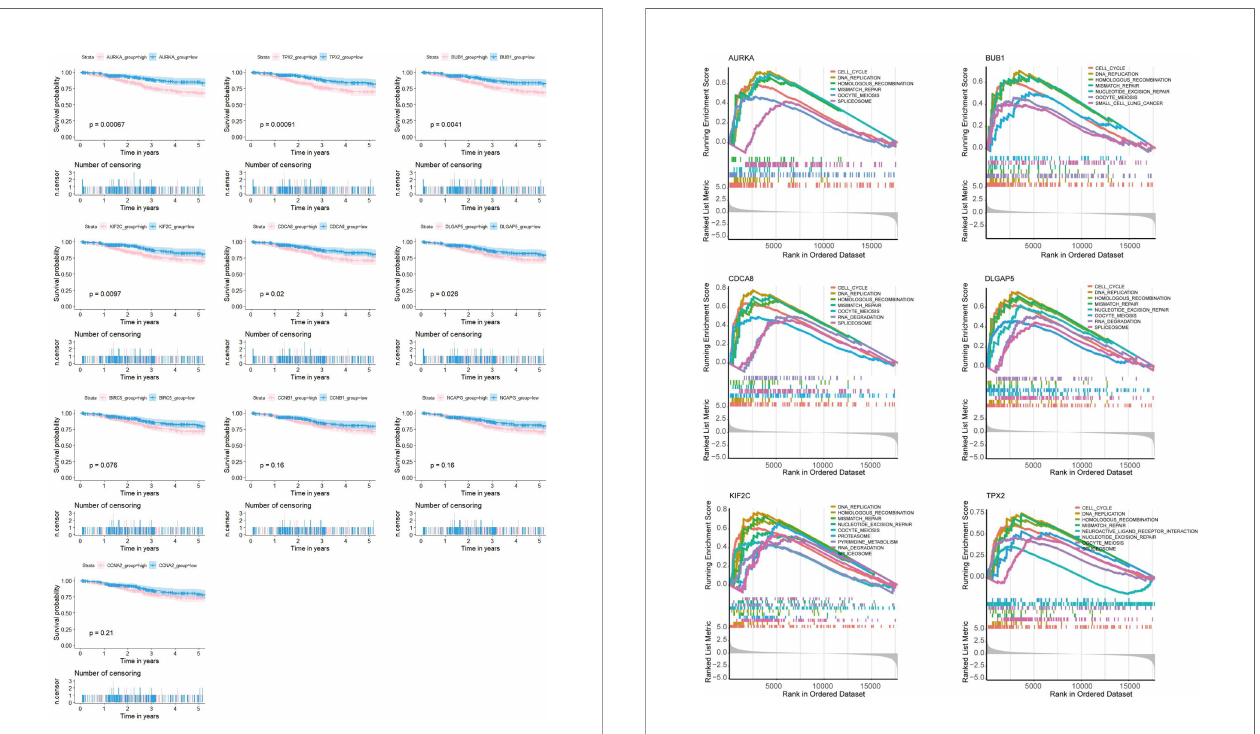
FIGURE 7 | Associations between the expression levels of candidate genes (AURKA, BIRC5, BUB1, CCNA2, CCNB1, CDCA8, DLGAP5, KIF2C, NCAPG and TPX2) and the 5-year OS for 524 patients with UCEC based on the TCGA dataset. 6 of the 10 genes were signi fi cantly negatively related to prolonged patient survival time (AURKA, BUB1, CDCA8, DLGAP5, KIF2C and TPX2).